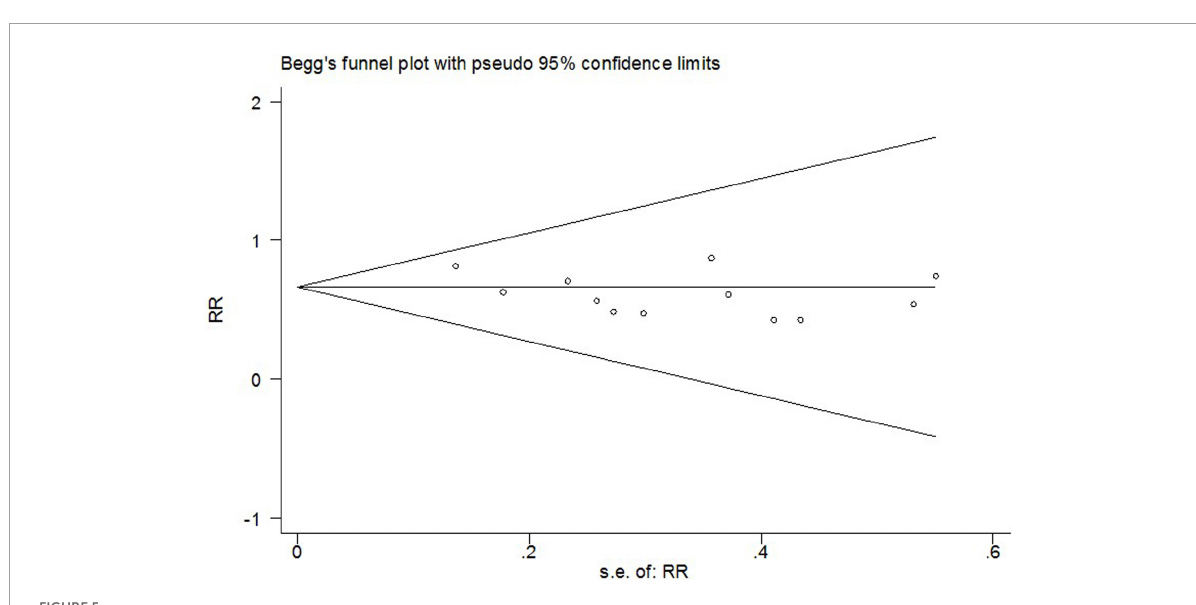
FIGURE5 Begg’s test funnel plots to assess the evidence of publication